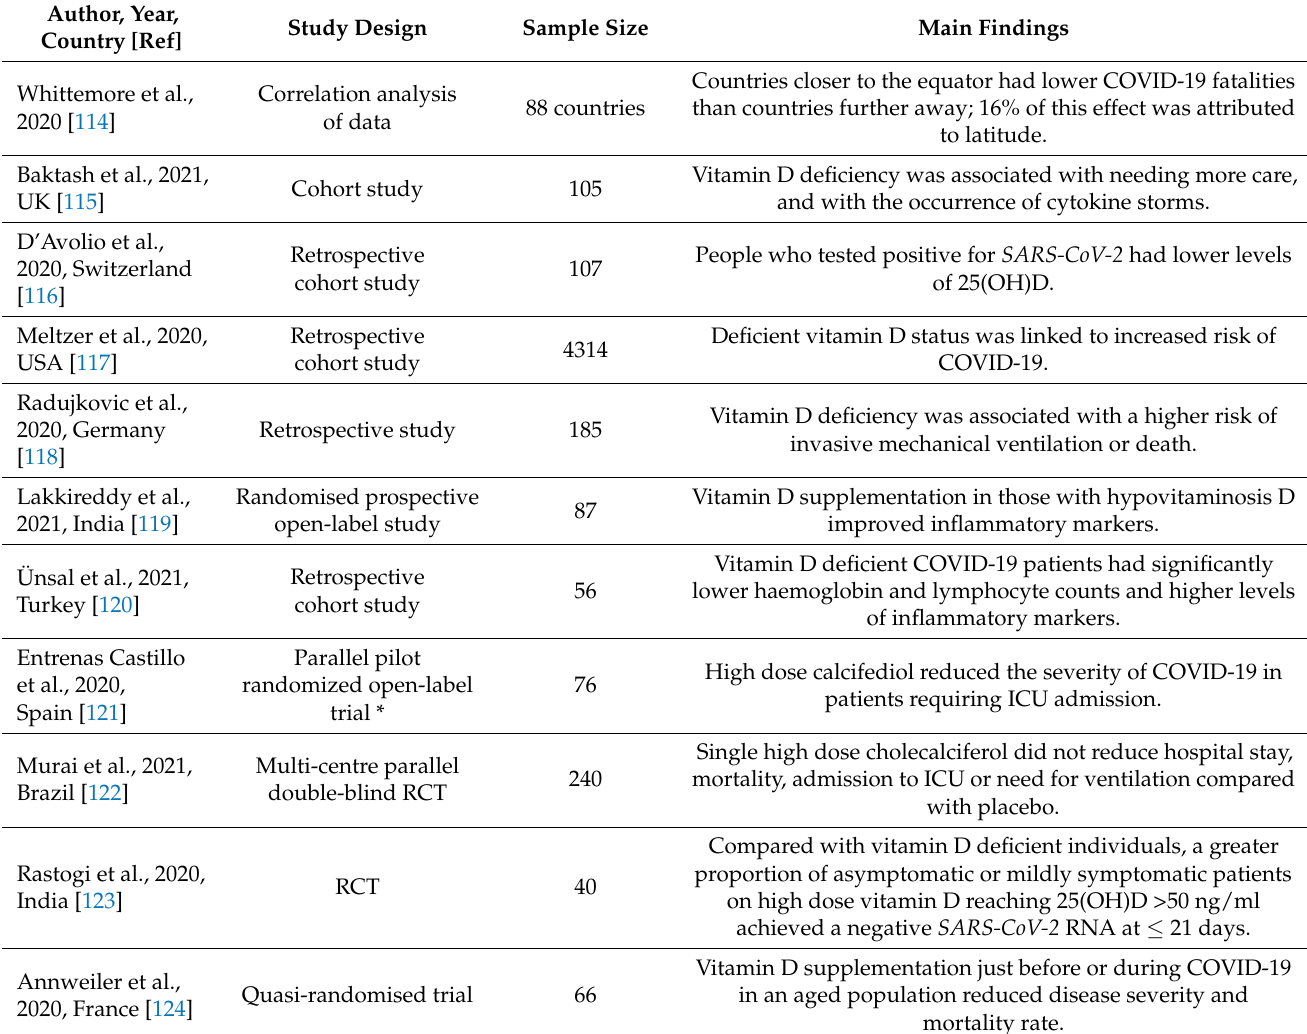
Table 1. Characteristics of studies examining the links between vitamin D and COVID-19